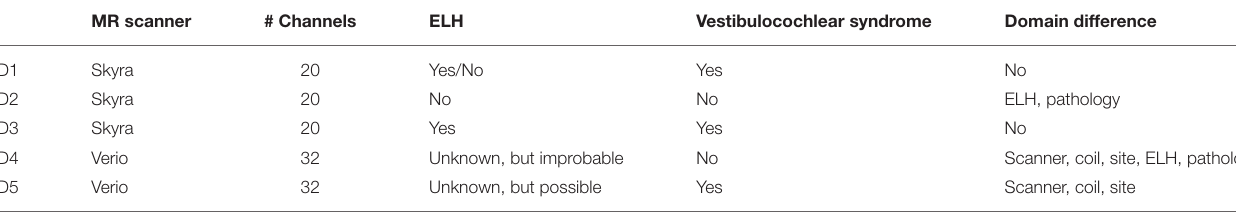
TABLE 1 | Domain differences between training (D1) and test (D2-D5)